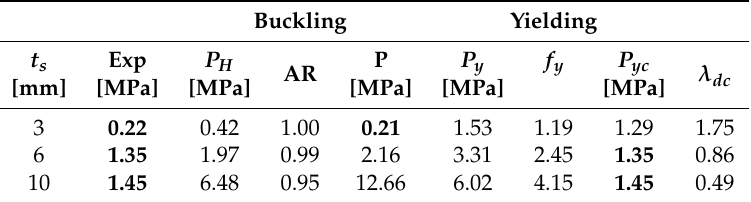
Table 9. Comparison between theoretical and experimental